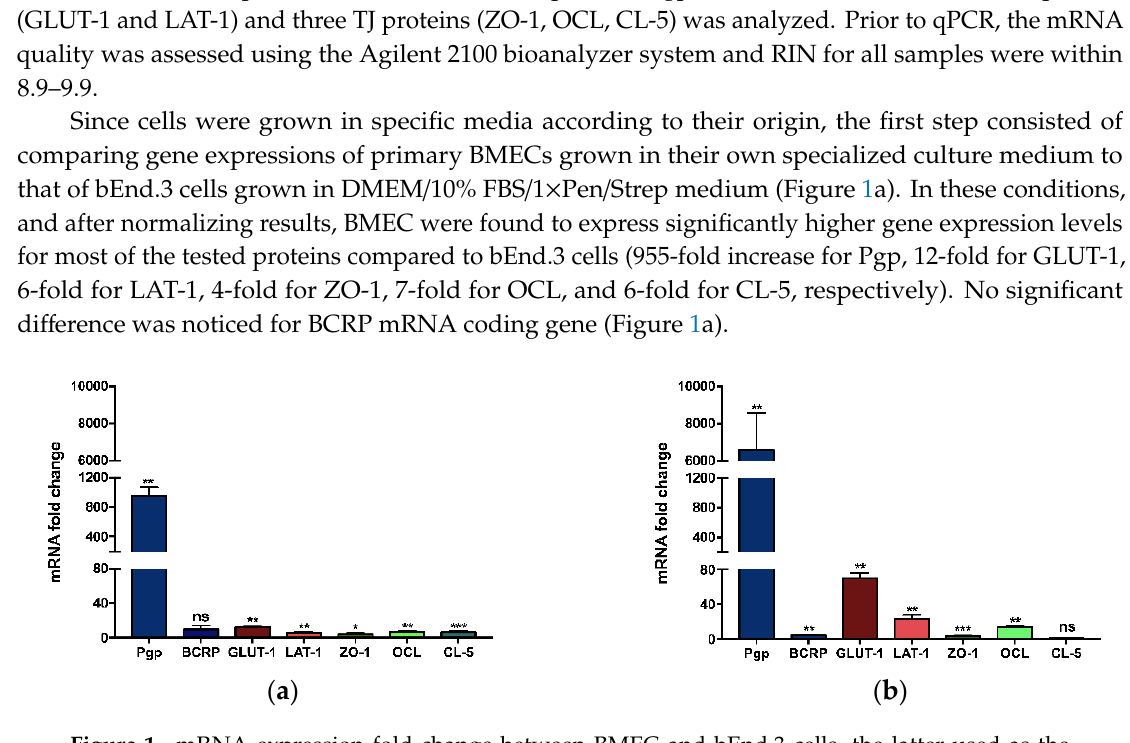
Figure 1. mRNA expression fold-change between BMEC and bEnd.3 cells, the latter used as the calibrator. Both cell monolayers were either grown in simple DMEM medium ( a ) or in specialized BMEC medium ( b ). Relative gene expression was calculated using the 2 − ∆∆ Ct method, with HPRT as the housekeeping gene and the bEnd.3 cell line as the calibrator. Bars indicate the average mRNA fold change ± SD ( n = 3). Data were analyzed using an unpaired t test with Welch’s correction (non-statistically significant (ns): p ≥ 0.0332, * p < 0.0332, ** p < 0.0021, *** p < 0.0002).